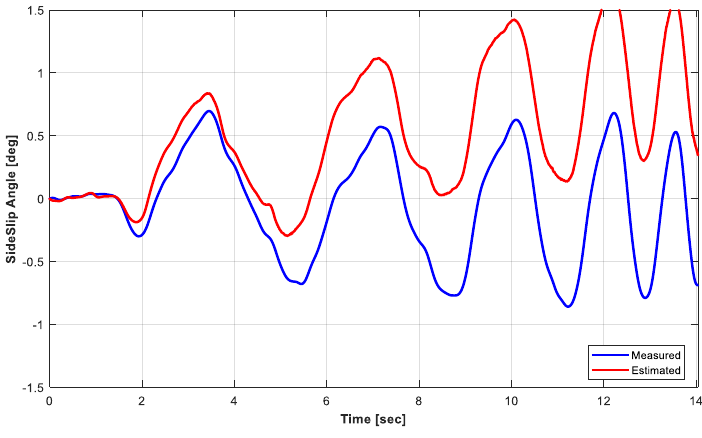
Figure 3. Performance of the kinematics-based observer.